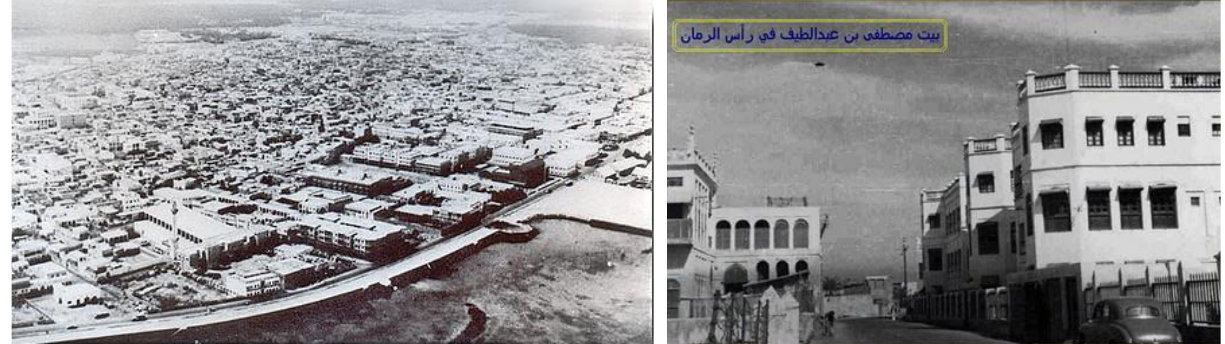
Figure 4: Aerial view of Manama, circa 1950s., Droodkin, (Droodkin, 2007)